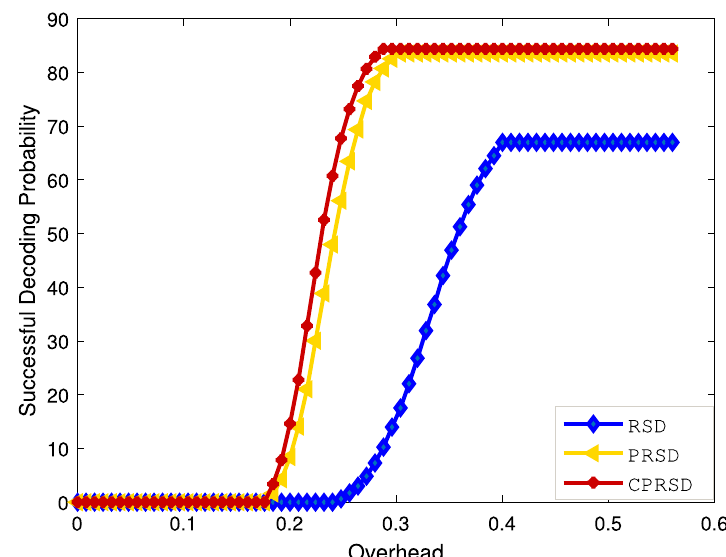
Fig. 13 Successful decoding probability with proposed decoding process for k = 250 in removal state